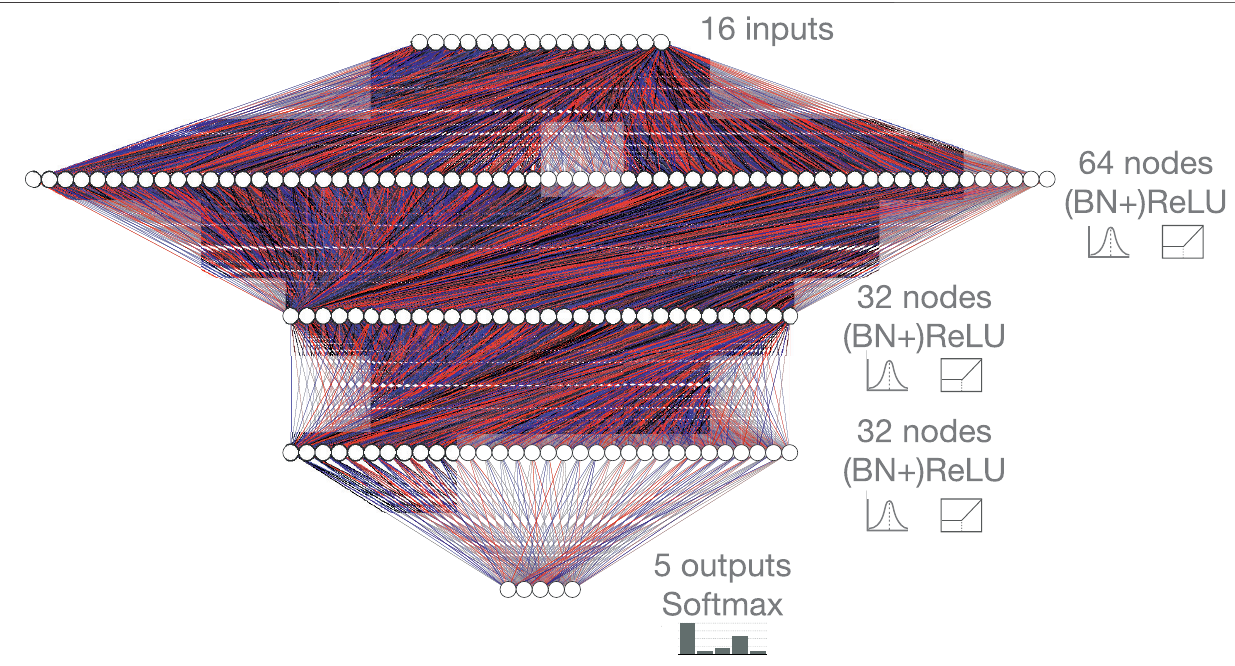
FIGURE1| Baselinefully-connectedneuralnetworkarchitecture,consistingof16inputs, fi vesoftmax-activatedoutputs,andthreehiddenlayers.Thethreehidden layers contain 64, 32, and 32 hidden nodes each with ReLU activation. A con fi guration with batch normalization (BN) layers before each ReLU activation function is also considered. The red and blue lines represent positive and negative weights, respectively, and the opacity represents the magnitude of each weight for this randomly initialized network.